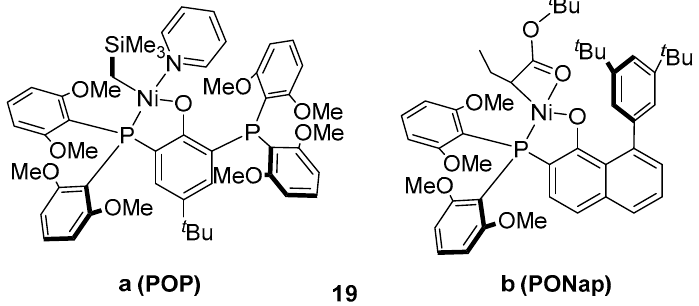
Figure 16. Neutral P, O-Chelated Nickel Catalysts POP-Ni-py ( 19a ) and PONap-Ni-py ( 19b ).